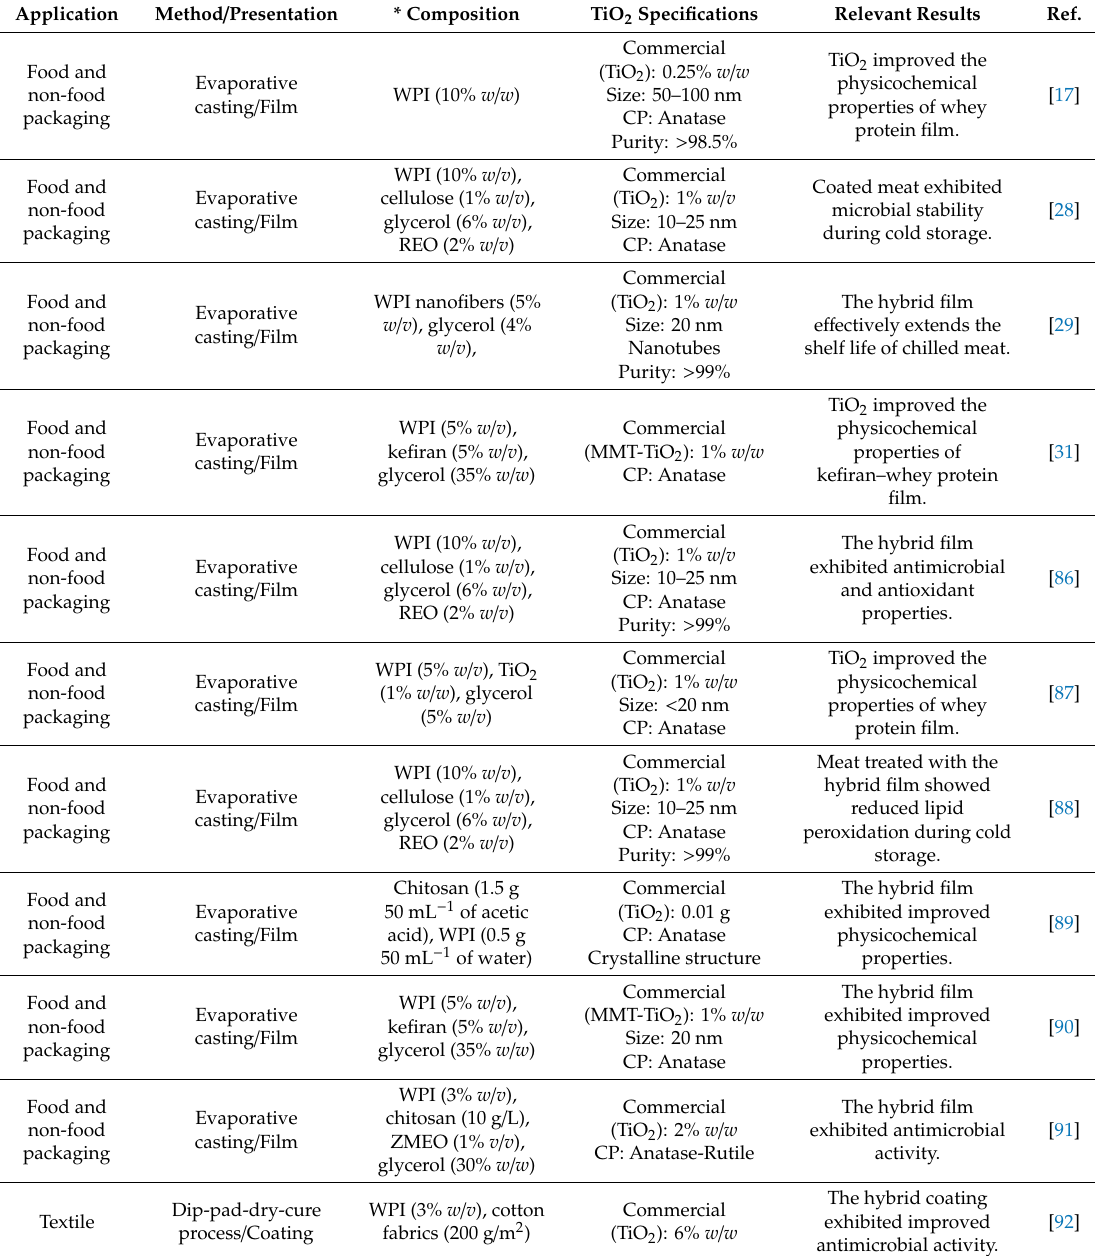
Table 5. E ff ect of TiO 2 incorporation on whey protein matrix